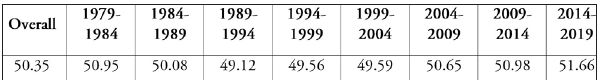
Table 3: Median age throughout the eight parliaments, at the start of a term